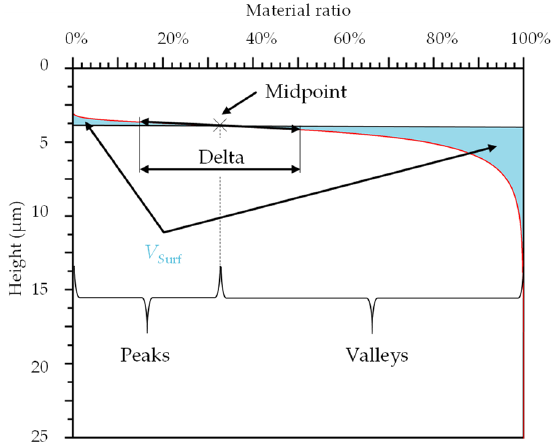
Figure 3. The picture represents the new surface parameter, V Surf . As an example, an MRC for a face-turned surface before the pin-on-disc test is shown. To determine the V Surf , the areas below and above the MRC (light blue colour) are calculated by integration and added.